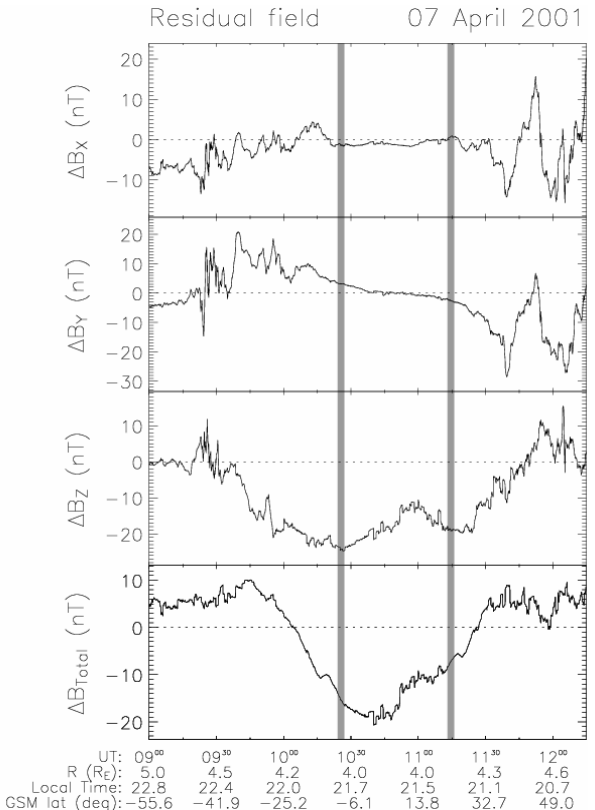
Fig. 4. GSM magnetic field perturbations, D B x , D B y , D B z , and D B Total (top to bottom) inferred using the FGM instrument on board the Cluster 3 satellite during 09:00 to 12:15 UT on 7 April 2001. The perturbations were estimated by subtracting a T96 model of the smooth, large-scale magnetic field variations. Figure 2 shows the Cluster 3 perigee was at ∼ 10:42 UT and Fig. 3 shows there were plasmapause crossings during 10:24–10:27 UT (entry) and 11:13–11:16 UT (exit). The plasmapause crossings have been shaded in this figure.